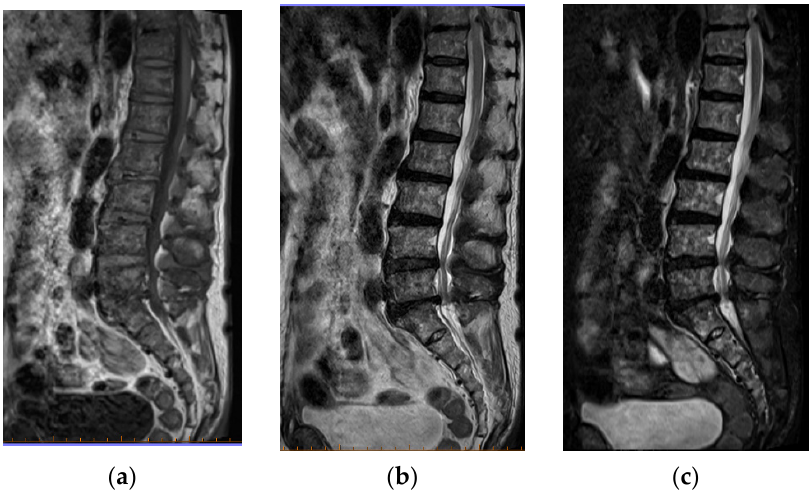
Figure 3. Magnetic resonance imaging (MRI) of the lumbar spine. ( a ) T1-weighted image. ( b ) T2-weighted image. ( c ) Fat-suppressed T2-weighted image. Abnormally low signal intensity was observed over the entire lumbar spine on T1- and T2-weighted images.